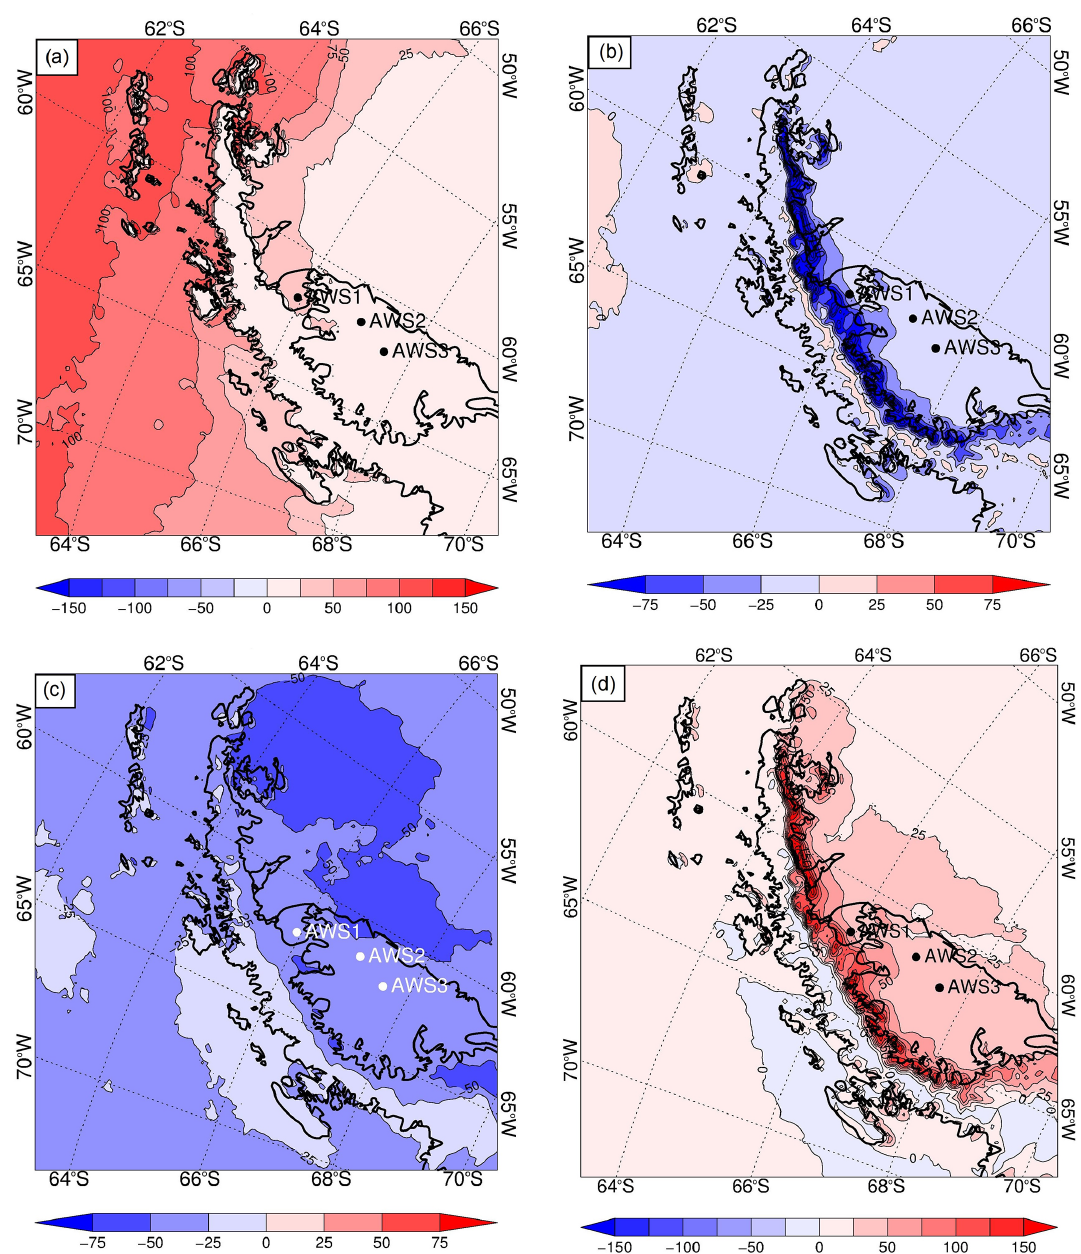
Figure 6. The energy (a) , latent heat (b) , net longwave (c) and sensible heat (d) fluxes as a composite of all föhn events from 2009–2012 in